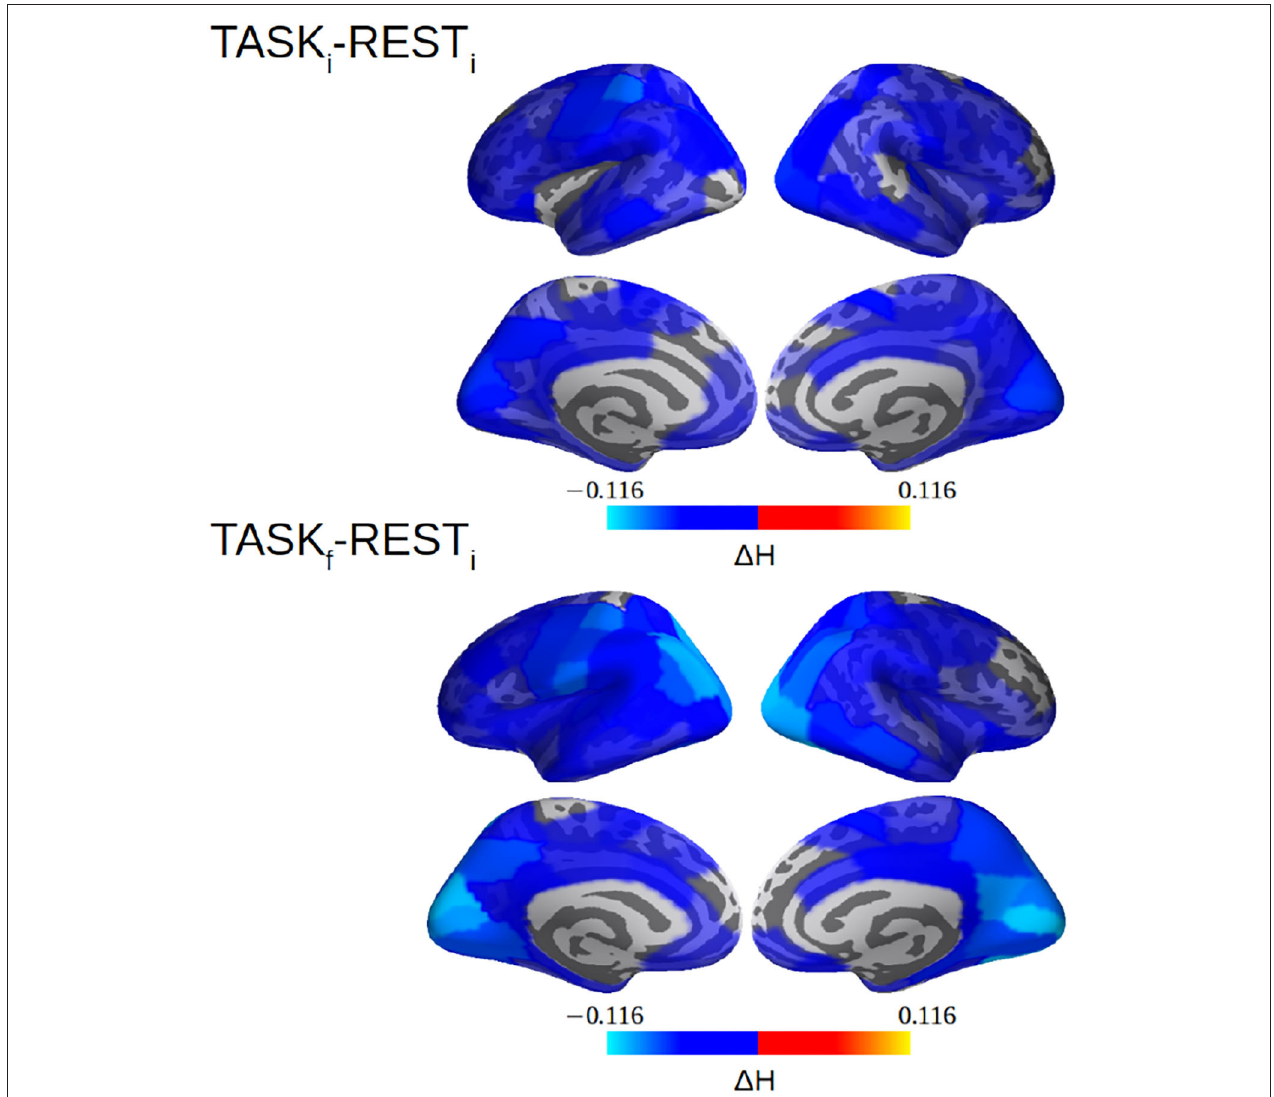
FIGURE 9 | selfsimilarity ( H ) differences between REST i and TASK i and between REST i and TASK f . The decrease in selfsimilarity from rest to task is strengthened with training, i.e., from TASK i to TASK f , and more heavily in the parieto-occipital (hMT+, visual cortices, V1/V2/V4) regions involved in task performance. Note that a value of H was computed per cortical label here. See La Rocca et al. (2018b) for methodological